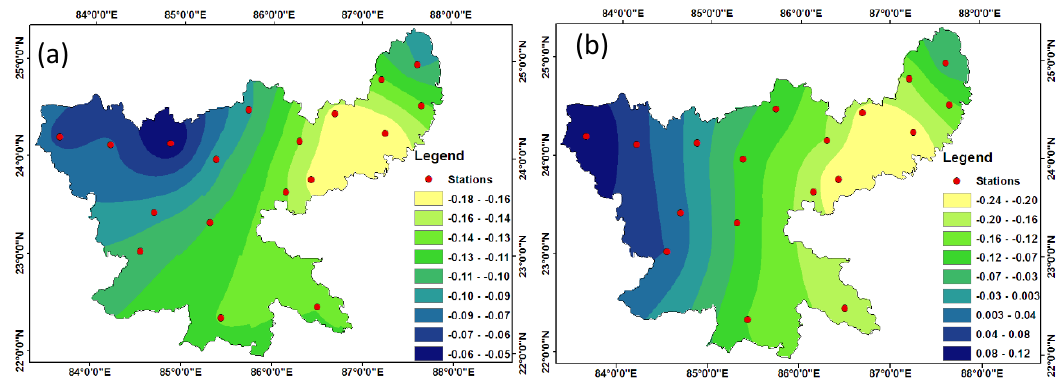
Figure 11. Spatial distribution of temporal change in winter rainfall during 1901 to 2002 ( a ) and from 1952 to 2002 ( b ).